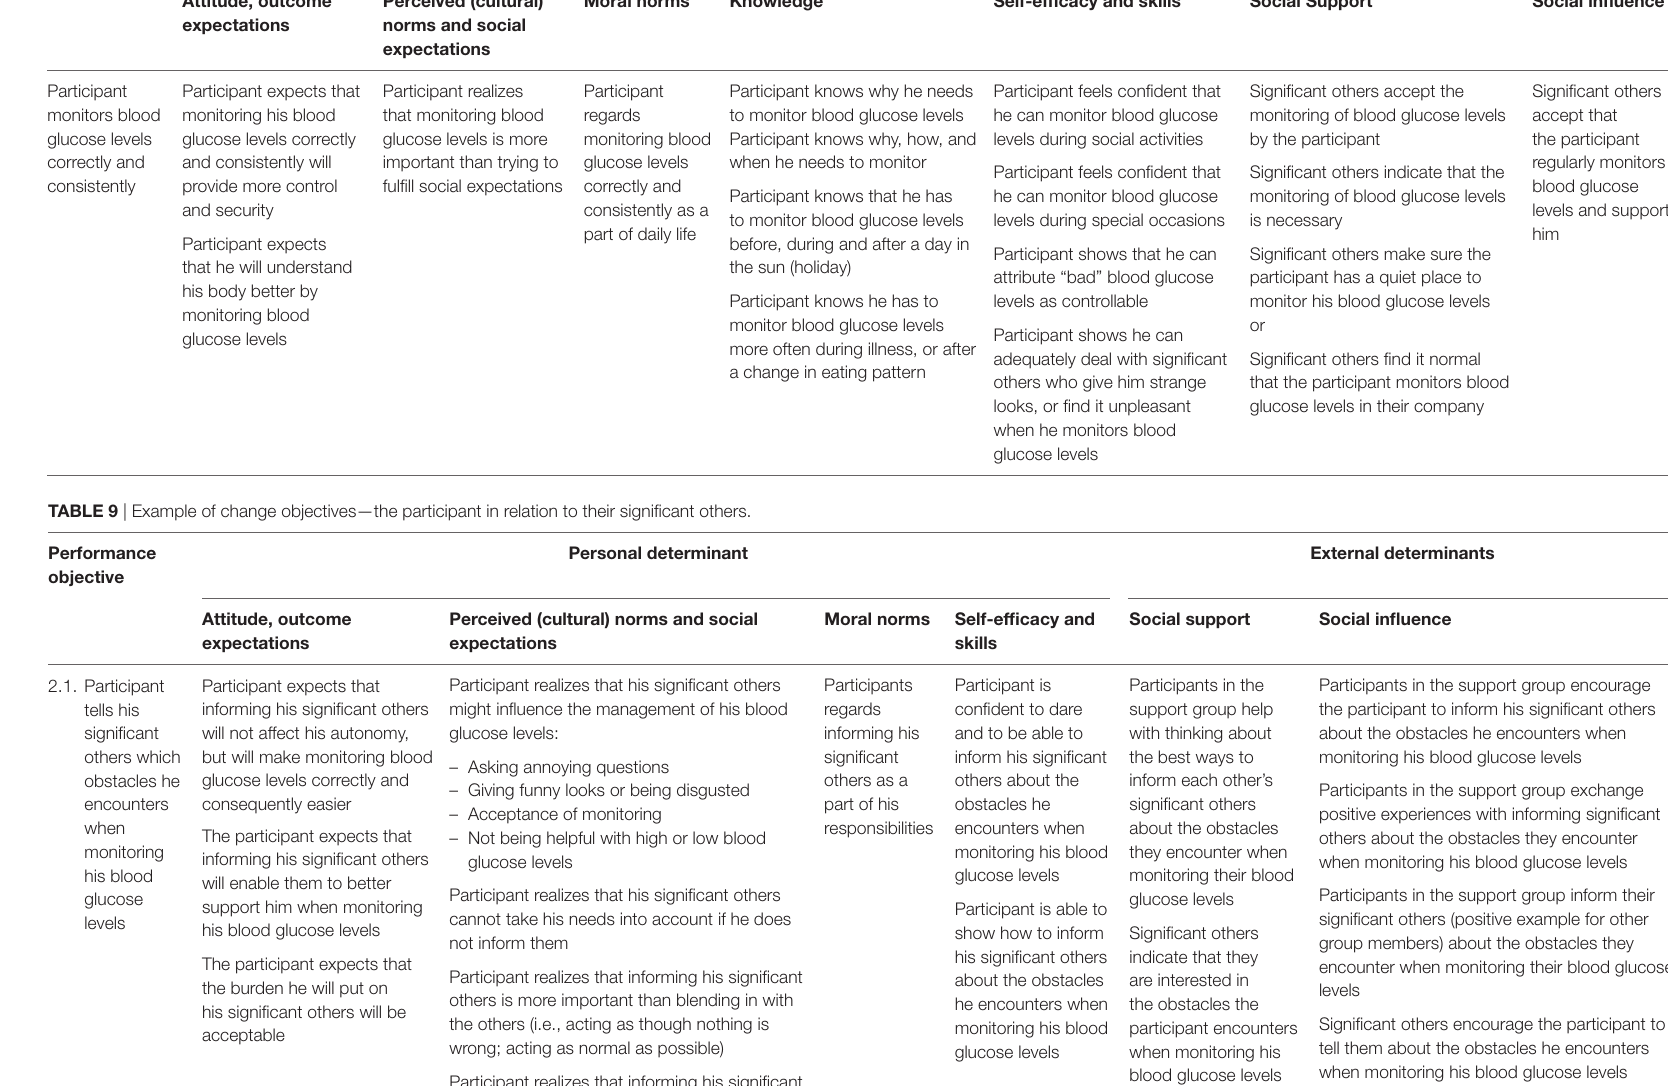
TaBle 8 | Example of change objectives—the participant. Performance objective